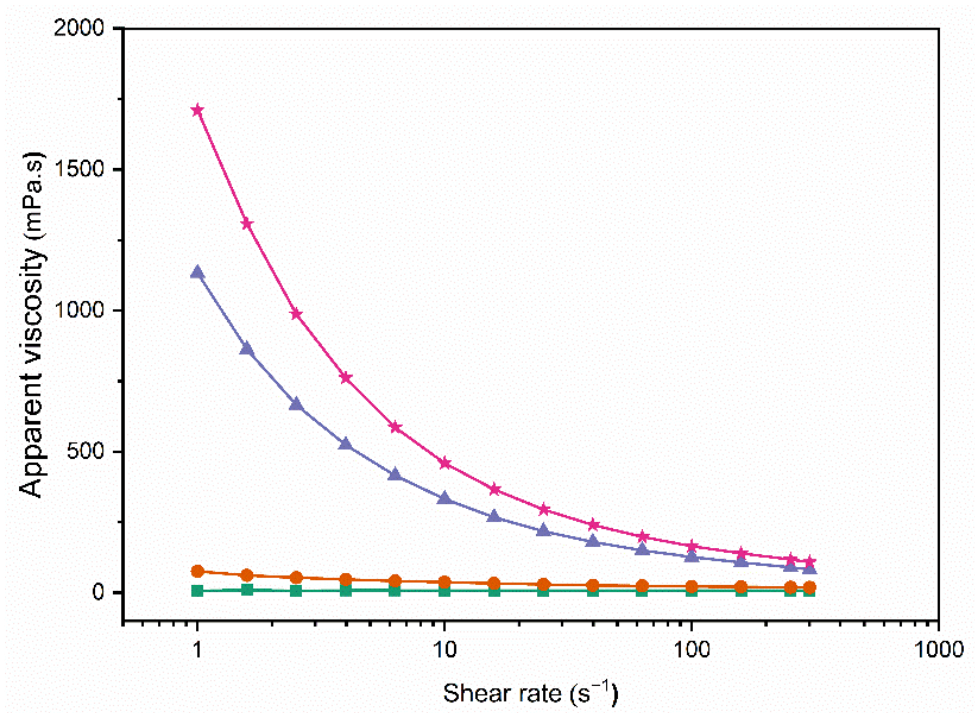
Figure 1. Apparent viscosity of the 50%-75 ◦ C (green square), 50%-100 ◦ C (orange circle), 60%-75 ◦ C (purple triangle), and 60%-100 ◦ C (pink star) IMF feed emulsions versus shear rate (1–300 s − 1 ).